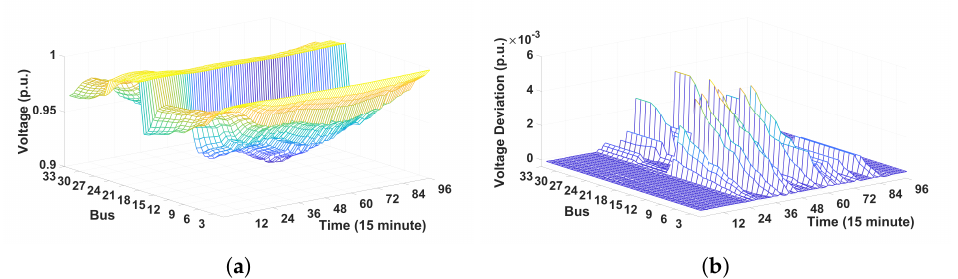
Figure 14. Voltage profile and voltage deviation for 32 buses during 24 h. ( a ) Voltage magnitude after the MCS dispatch. ( b ) Voltage deviation ( ω 1 = 0.5, ω 2 =